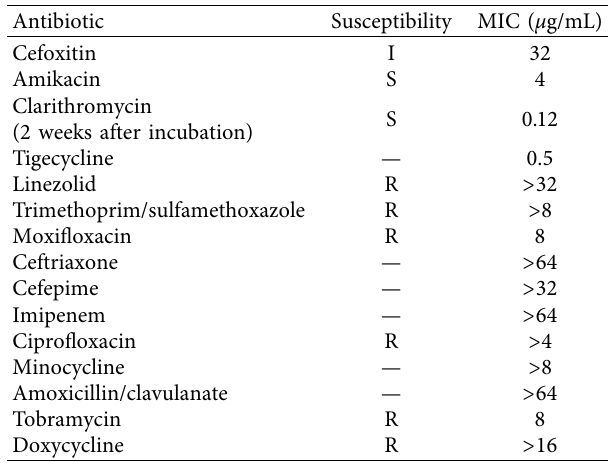
Table 1: In vitro susceptibility and minimum inhibitory con- centration (MIC) of Mycobacterium massiliense